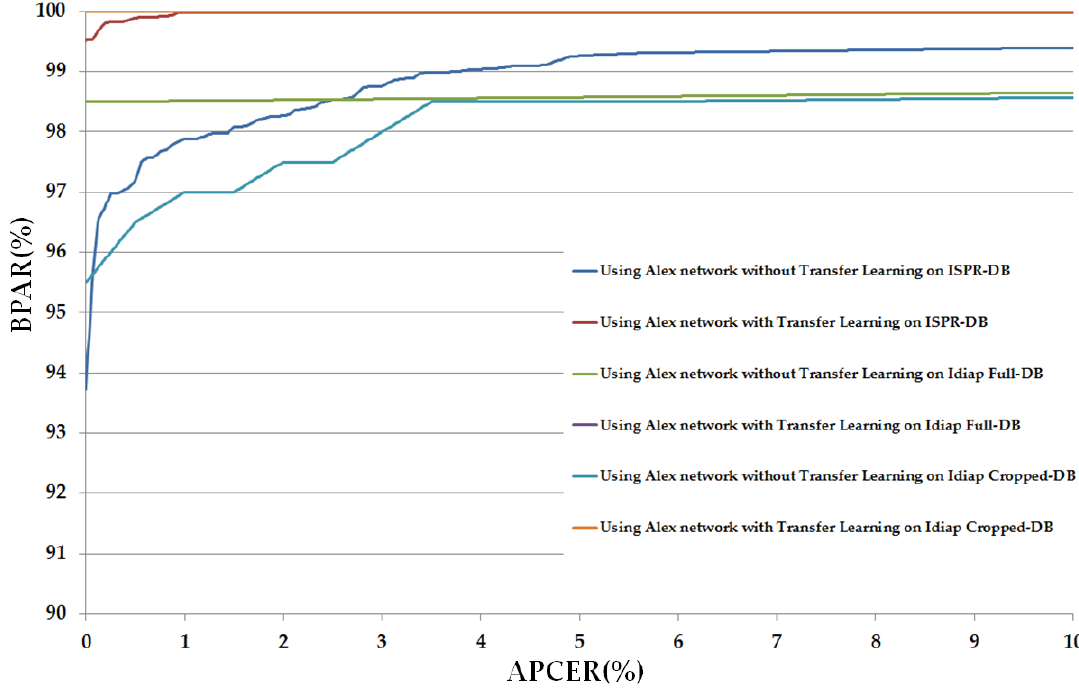
Figure 7. The DET curves of PAD method based on Alex network using three different databases: ISPR-DB, Idiap Full-DB and Idiap Cropped-DB database; and two training modes: with and without applying the transfer learning method.